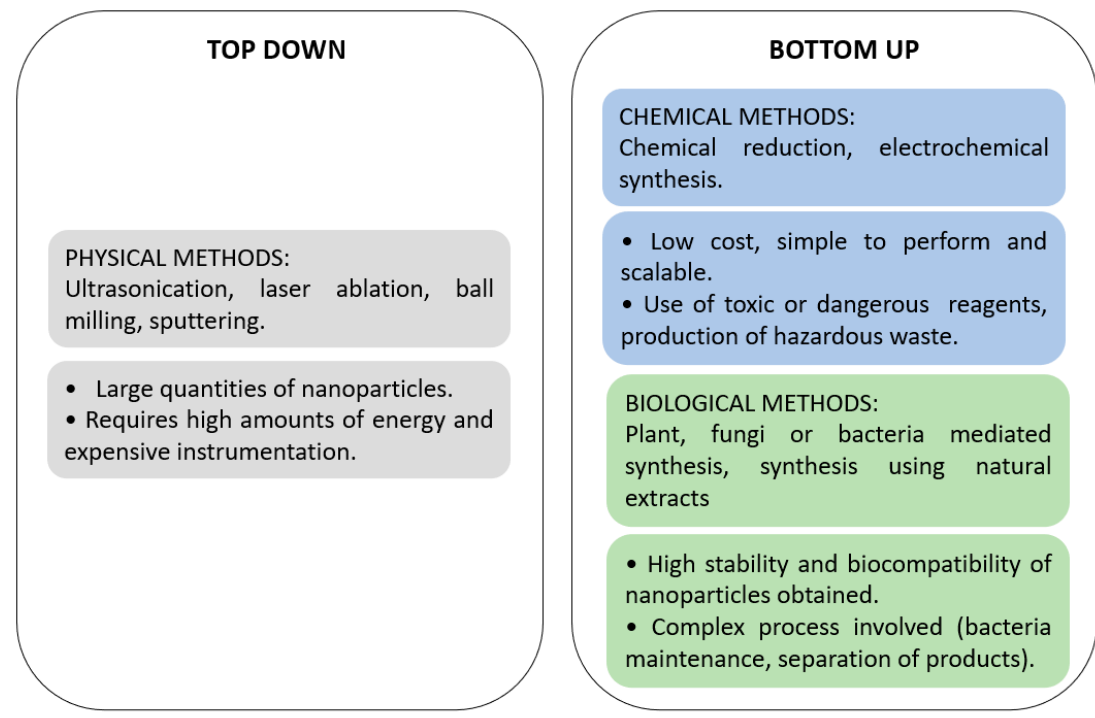
Figure 1. Synthesis methods for AgNPs preparation and its characteristics.